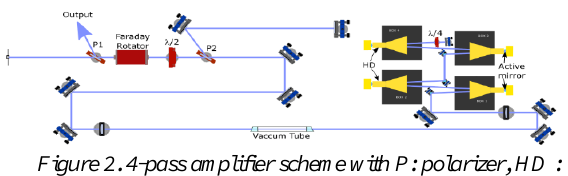
Figure 2. 4-pass amplifier scheme with P: polarizer, HD : hollow duct,  /2 : half wave